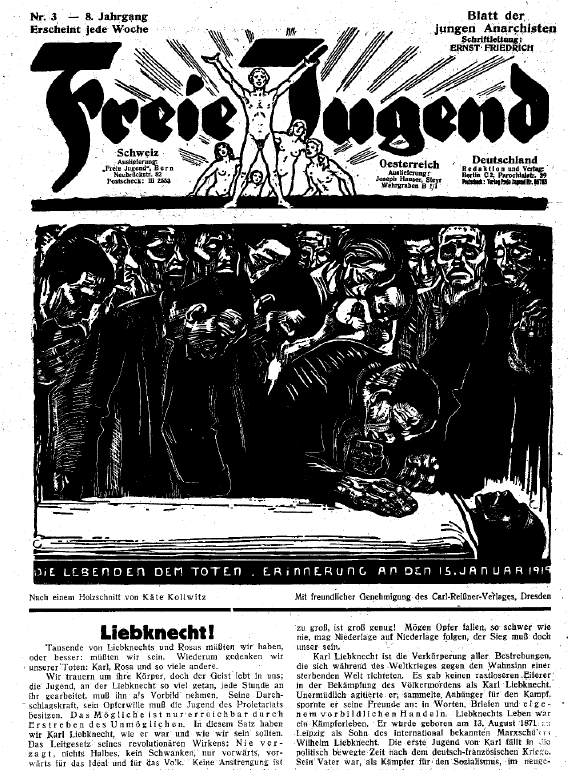
Figure 5. Front page of Freie Jugend , Week 3, Volume 8 (c. 21 January 1926), illustrated by Kollwitz’s Memorial to Karl Liebknecht (1920).